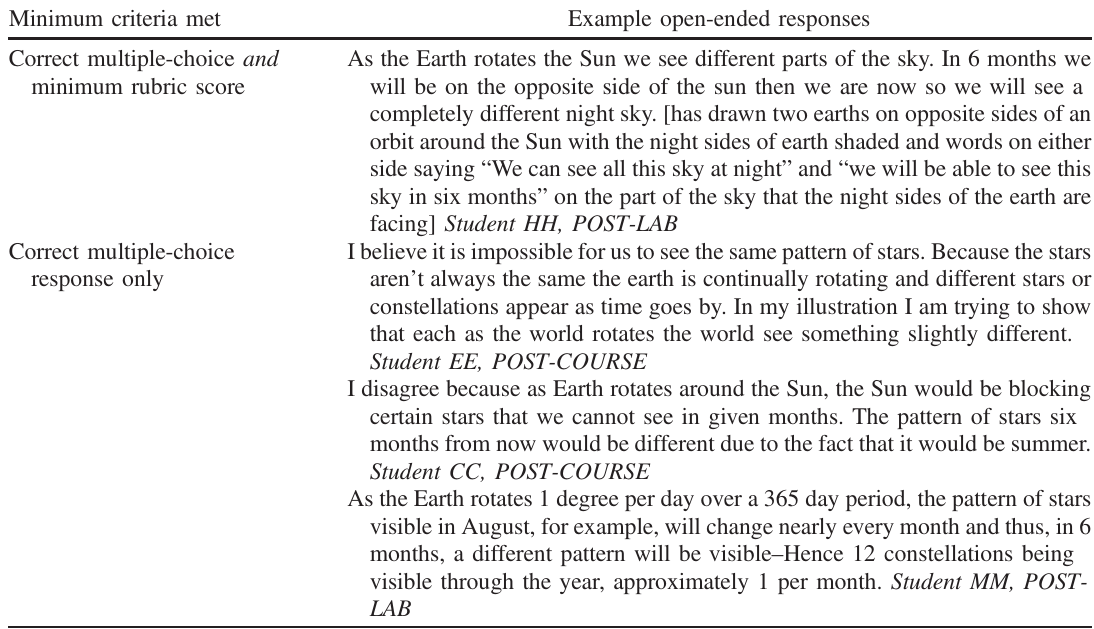
TABLE VI. Example open-ended responses given for the assessment about the changing appearance of the night sky over the course six